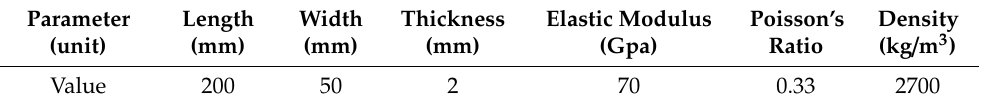
Figure 9. Setup of the single-beam test rig: ( a ) the schematic plot; ( b ) the photo of the test rig, where the red part is the actuator, and the clamping is realized by two bolts. Table 1. Parameters of the aluminum beam.